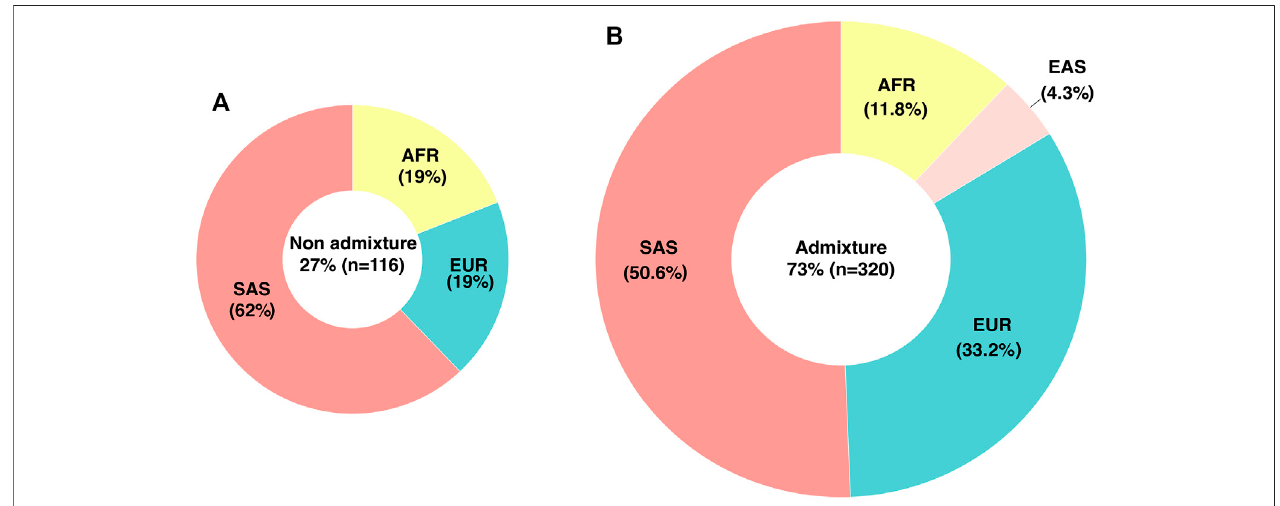
FIGURE1| GeneticancestryandadmixtureinthestudiedpopulationdeterminedbyWES. (A) Percentageanddistributionofindividualsclassi fi edasnon-admixed (B) Percentage and ancestry contribution of individuals classi fi ed as admixed. EUR, European; AFR, African; SAS, South Asian; EAS, East Asian.